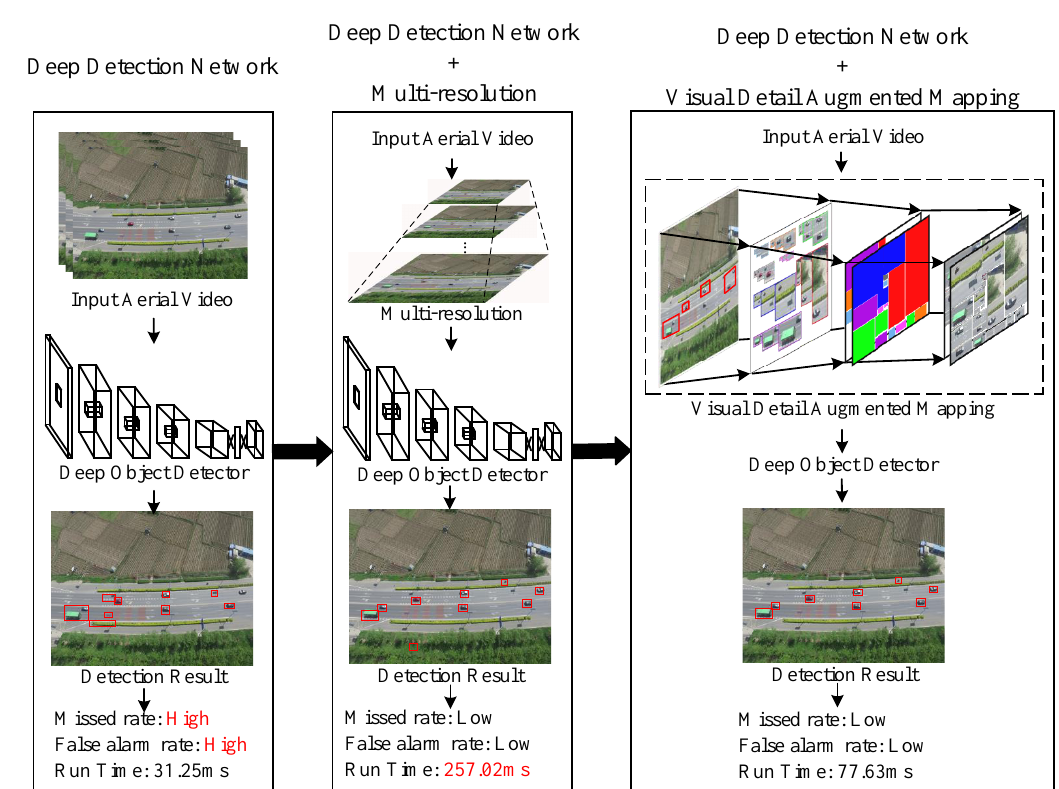
Figure 2. The research route of the proposed method. This paper investigates the problem of small aerial object detection. The general solution is based on the deep detection model, but direct detection causes high false alarm and miss rates. Another approach is to add multi-resolution processing before deep detection. However, this improves the detection performance and reduces the efficiency at the same time. In order to balance effectiveness and efficiency, this paper proposes a novel visual detail augmented mapping approach that maps small target regions to a new foreground space to allow better